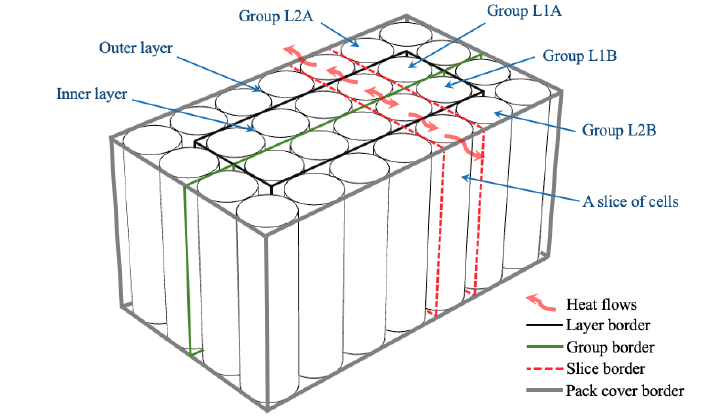
Figure 2. Pack geometry and heat flow in a battery pack consisting of Li-ion 18650